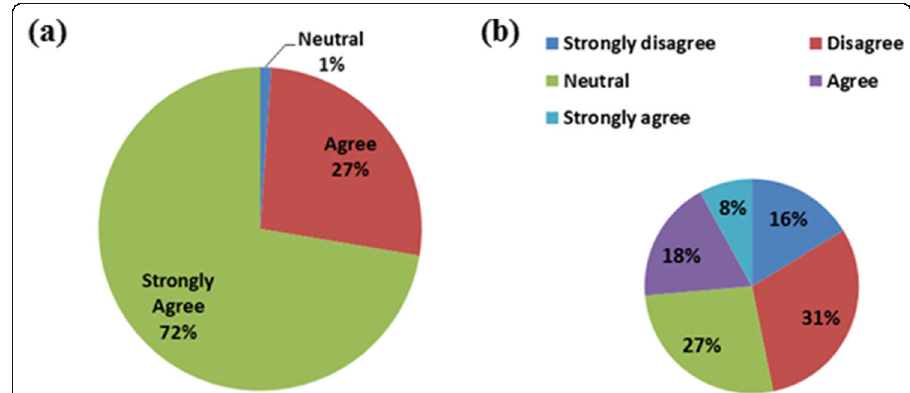
Fig. 2 Perception of participants towards OER in learning